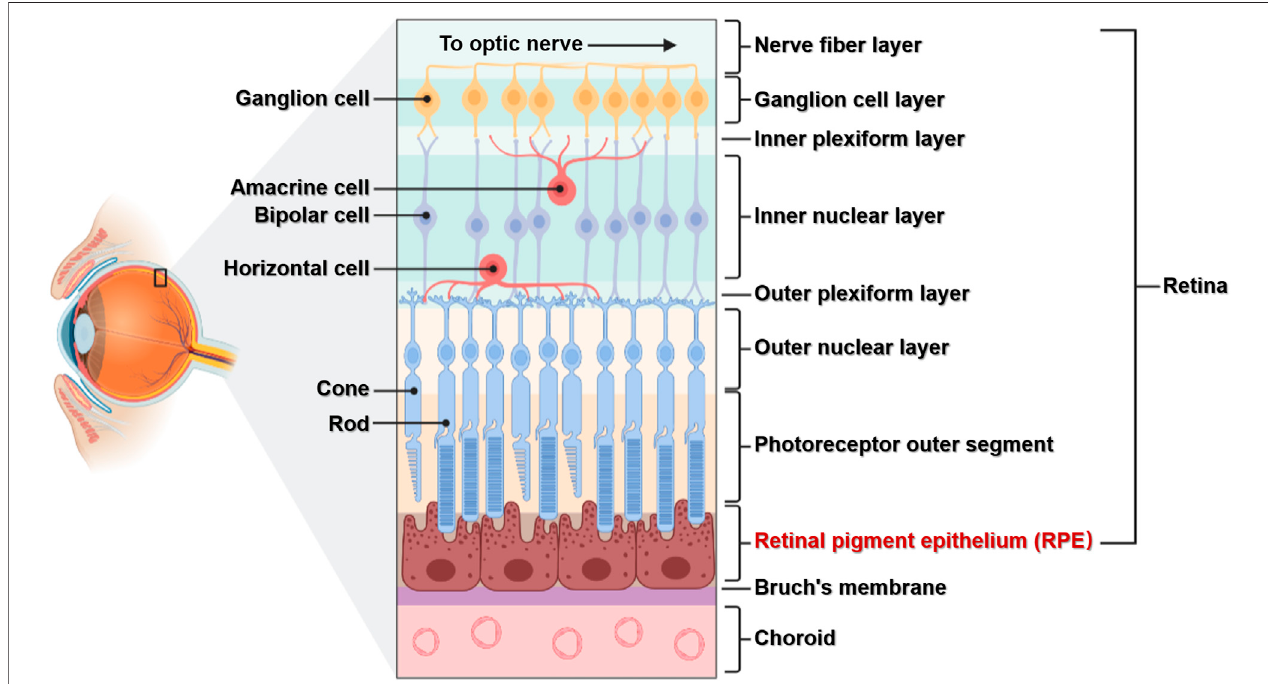
FIGURE 1 | The structure of the retina. The retina is composed of multiple layers and different cell types. The RPE is composed of a single layer of RPE cells, which are connected to the choroid membrane through Bruch ’ s membrane.